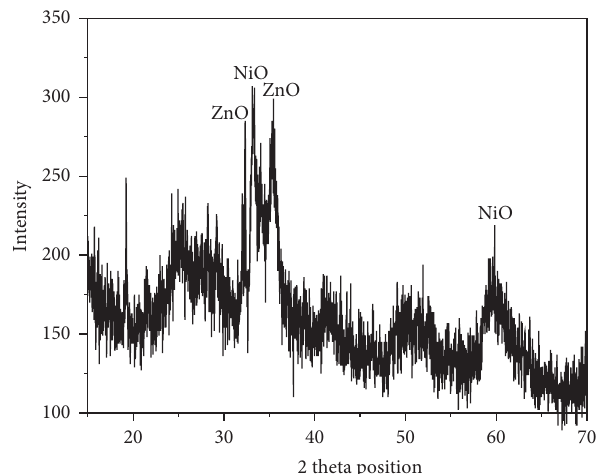
Figure 6: X-ray diffractogram of NiO-ZnO NC.